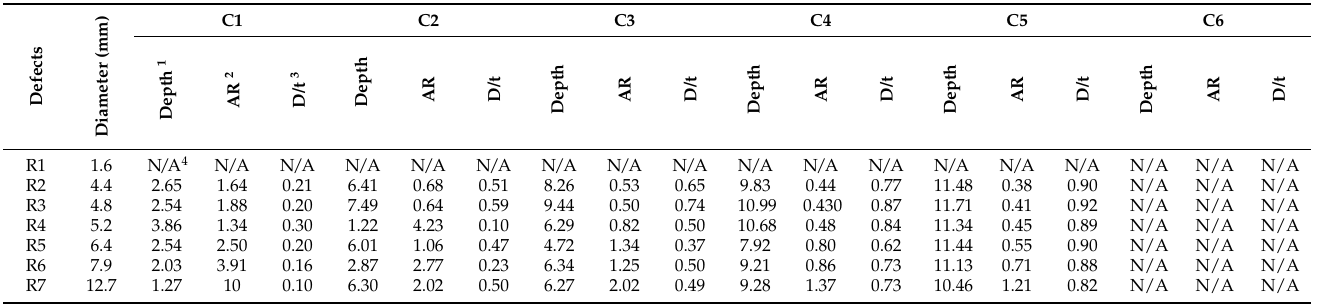
Table 5. Characteristics of the defects shown in Figure 2 created on the internal east side of the tank (wall thickness, t = 12.7 mm = 0.5 in).